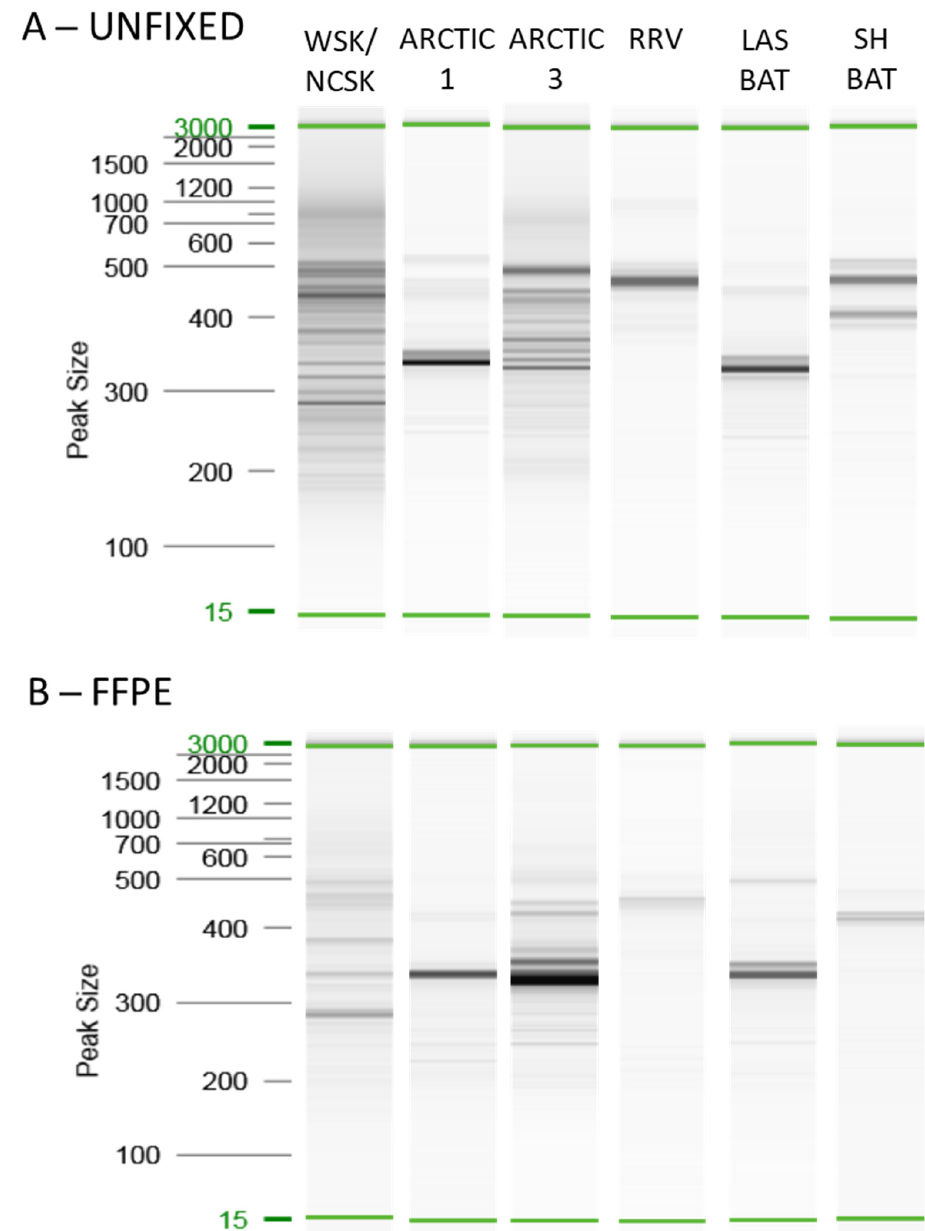
Figure 3. A comparison of amplicon profiles generated by the Ampliseq for Illumina protocol for fixed and FFPE samples of the same RABV variant. The cleaned sequencing library was analyzed by a QIAxcel system with the inclusion of a 15–3000 bp reference marker in each run. Results for unfixed samples ( A ) and FFPE samples ( B ) are shown for the following RABV variants: Western skunk/North Central skunk (WSK/NCSK) 04RABL00965, 92RABL01670; Arctic1 01RABN00053, 07RABN06558; Arctic3 91RABN05406, 17RABN00630; Mid-Atlantic raccoon (RRV) ME.2014.0197, 18RABN01852; Lasiurus bat (LAS BAT) V231, 94RABN04952; and Silver-haired bat (SH BAT) V077,